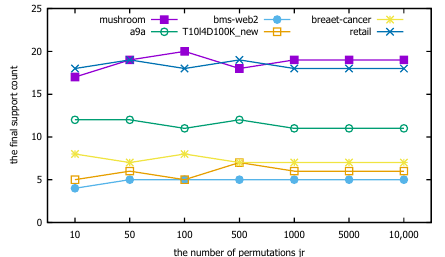
Figure 9. The number of replacement